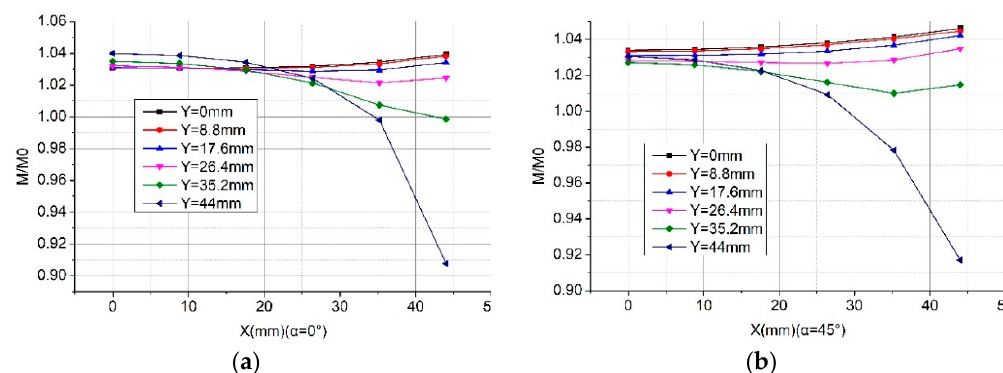
Figure 9. Calculated normalized mutual inductance vs. position when the primary conductor goes nonvertically through the Coil D. ( a ) α = 0°; ( b ) α = 45°.